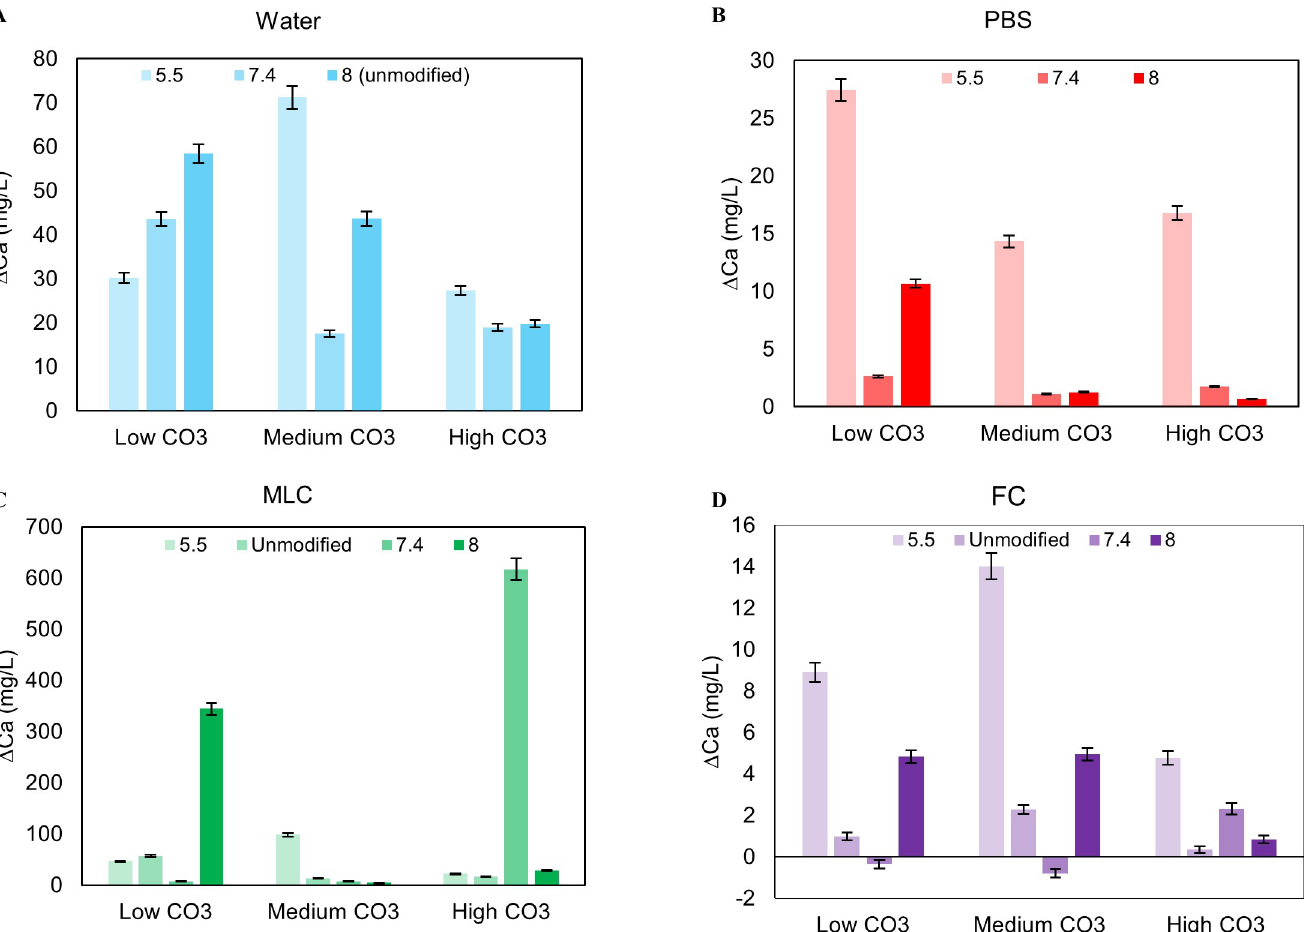
Fig 1. Change in calcium levels in the solutions after exposure. Calcium increased in all solutions, confirming apatite dissolution (A-D) . Generally, calcium levels in the solution increased as pH i decreased for PBS (B) . For water, MLC, and FC, there are no apparent trends (A, C, D) . Overall, water had the most calcium in the solution after exposure since there is less calcium in water compared to the other solutions (A) .